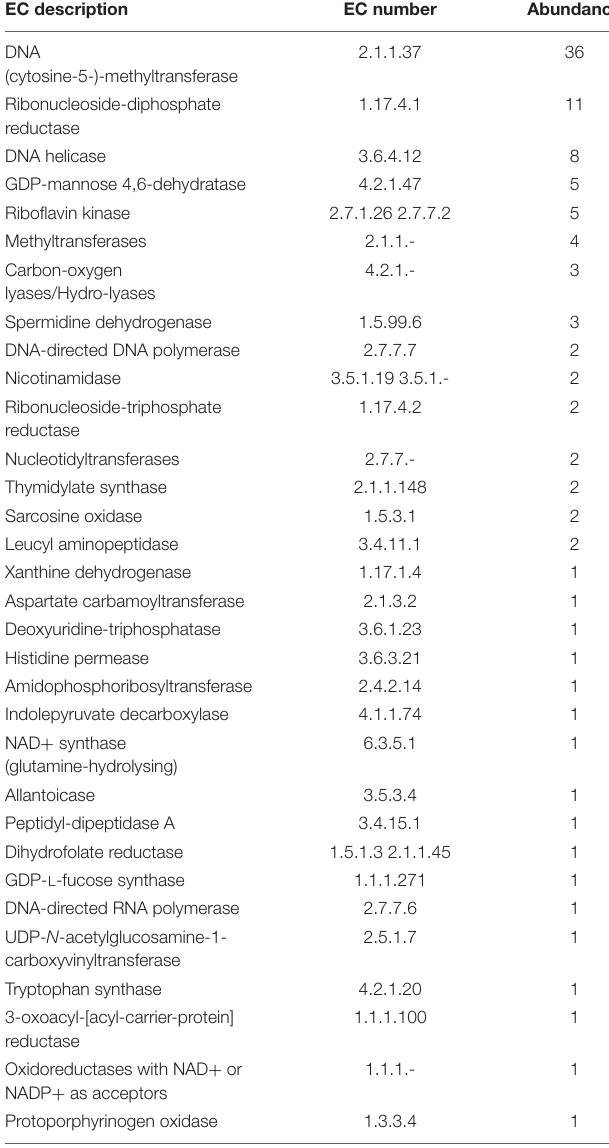
TABLE 2 | KEGG ontology (KO) EC numbers for the Shark Bay virome annotations